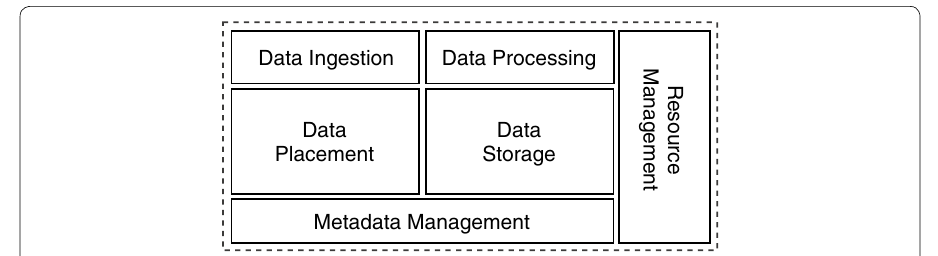
Fig. 1 A high-level block diagram of a Big Data management